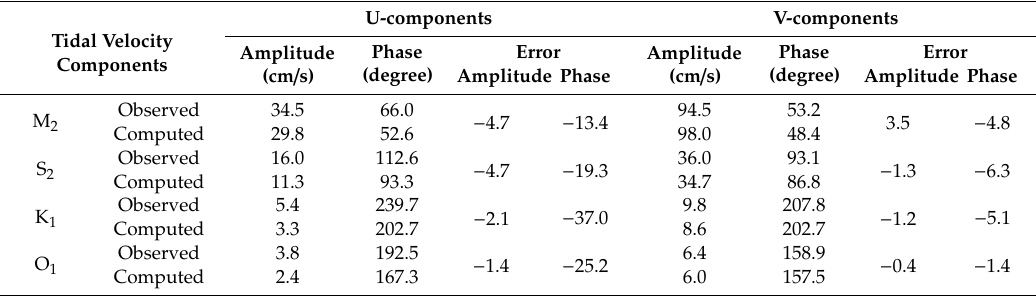
Table 2. Comparison of observed and computed tidal velocity harmonic constants for M 2 , S 2 , K 1 , and O 1 at C-1.